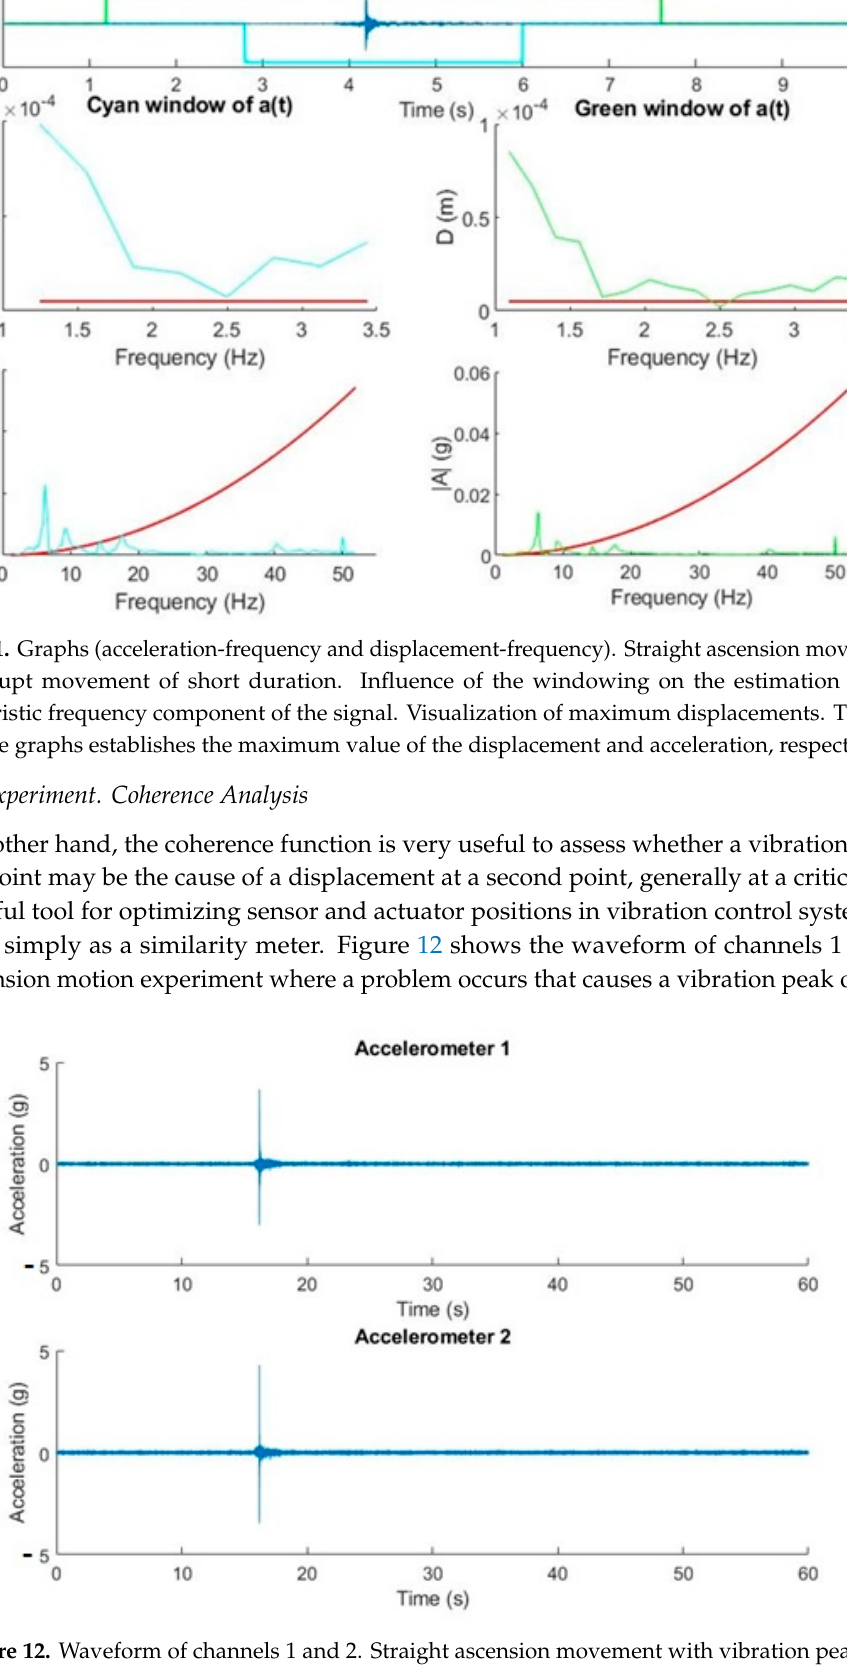
Figure 13. Coherence analysis between channels 1 and 2.